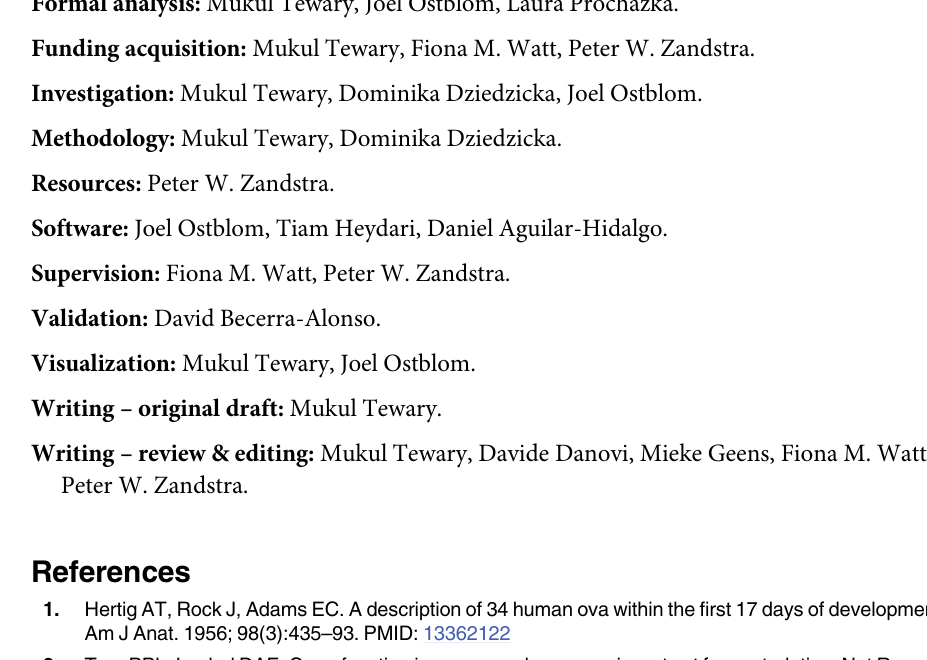
S2 Table. List of primers used in this study. S3 Table. List of antibodies used in this